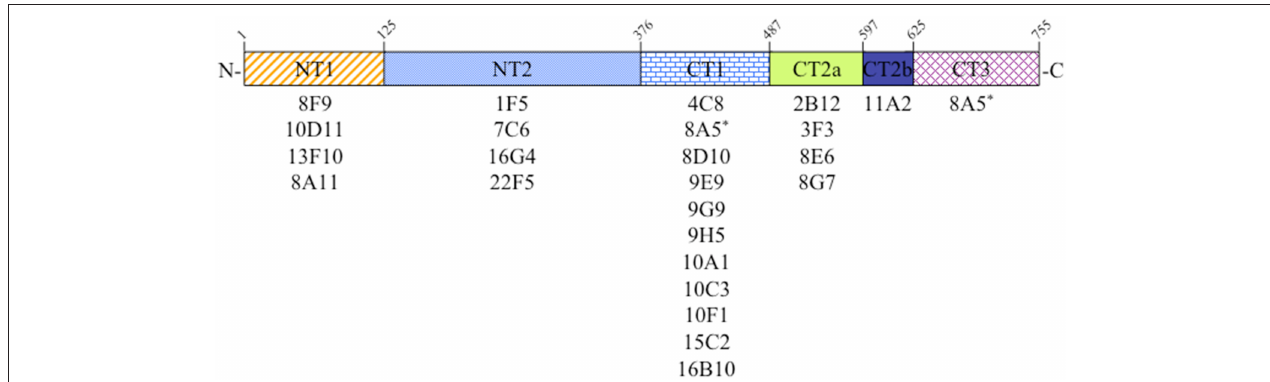
FIGURE 1 | Epitope mapping analysis of Sec6 monoclonal antibodies. Antibodies produced by 24 different hybridomas were tested for binding specificity to seven recombinant Sec6 fragments, defining 6 distinct protein segments. Amino acid residues marking the boundaries of these segments in rat Sec6 are shown above each. See text for